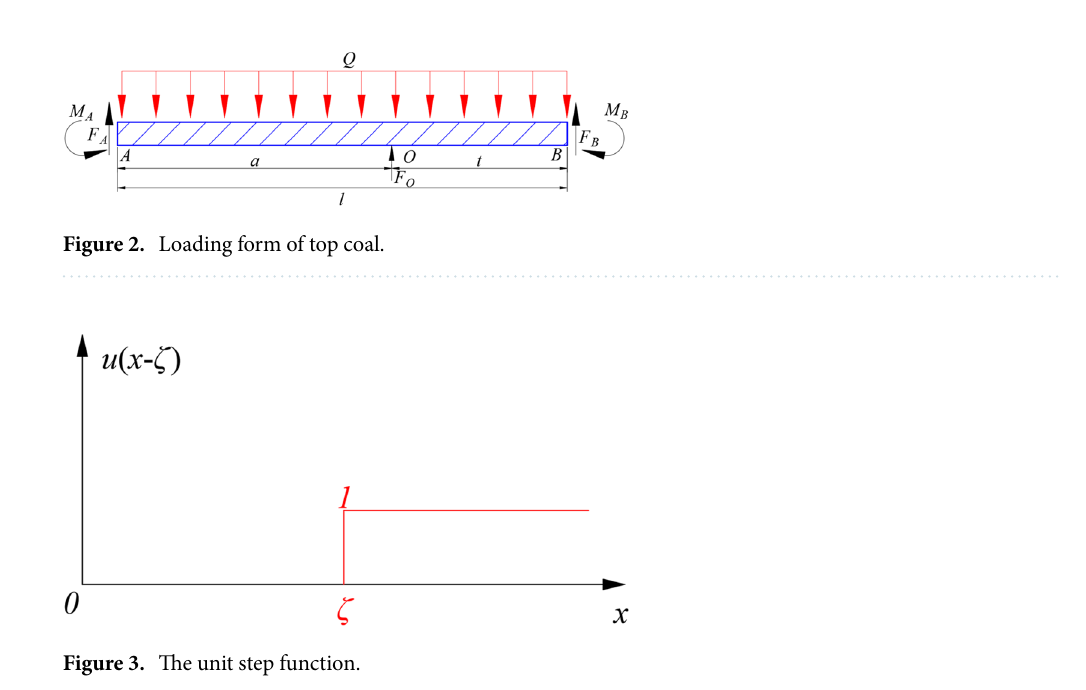
Figure 1. The location of working face 12,203 of Huojitu minefield, Shaanxi, China.